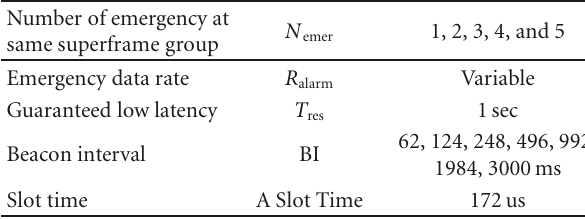
Table 2: Simulation